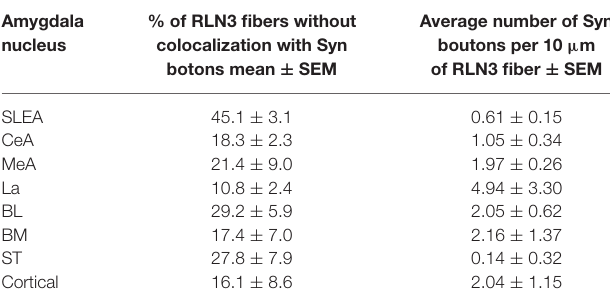
TABLE 3 | Quantitative estimation of the colocalization of synaptophysin (syn) and relaxin-3 in the different nuclei of the amygdala . Amygdala % of RLN3 fibers without Average number of Syn